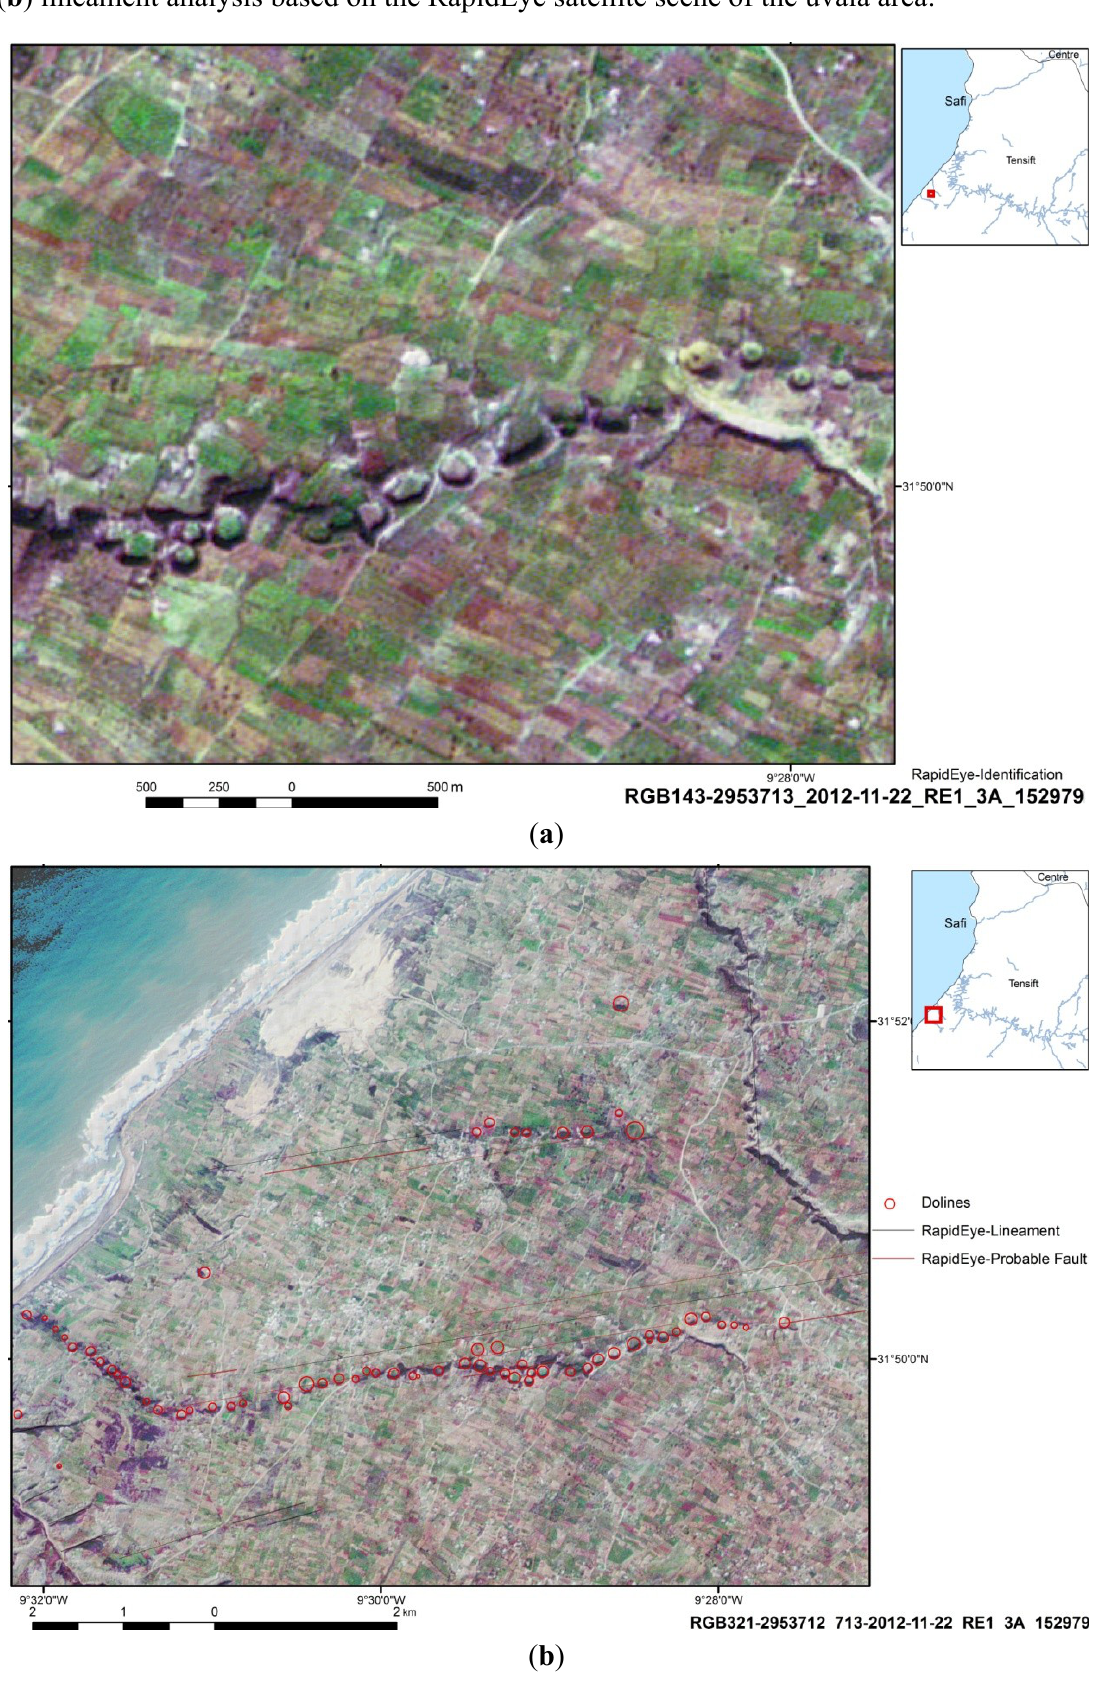
Figure 15. ( a ) Uvalas in a linear arrangement in the south of the Tensift-river as visible on a RapidEye scene (acquisition date: 22 November 2012, 5-m spatial resolution) and ( b ) lineament analysis based on the RapidEye satellite scene of the uvala